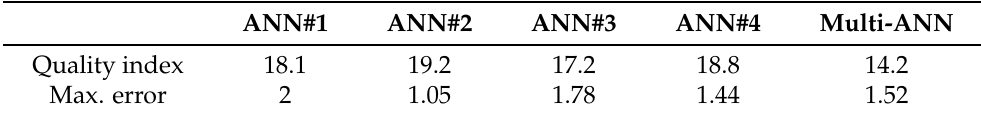
Table 1. Sample results for the presented set of trained